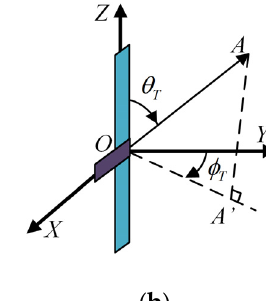
Figure 2. Spherical coordinate of discrete antenna. ( a ) Reader antenna with half-wave square patch. ( b ) Passive tag antenna with half-wave dipole.